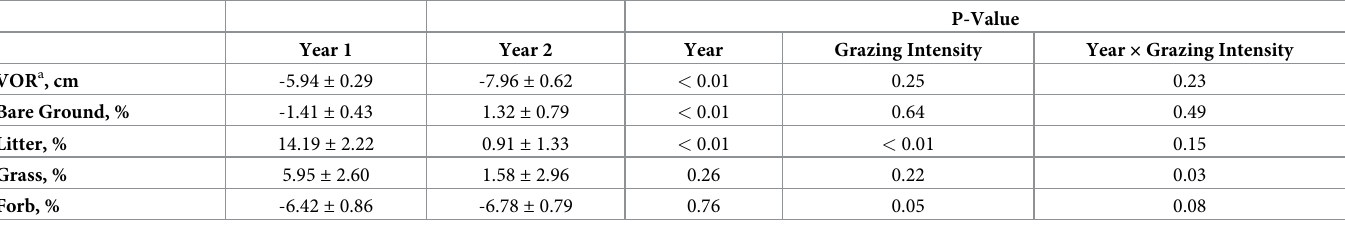
Table 5. Pre- post differences in mean ( ± SE) visual obstruction and residual cover classifications by year for cattle grazing dormant rangeland in 2016 – 2017 & 2017 – 2018 at the Northern Agricultural Research Center Thackeray ranch, Havre,